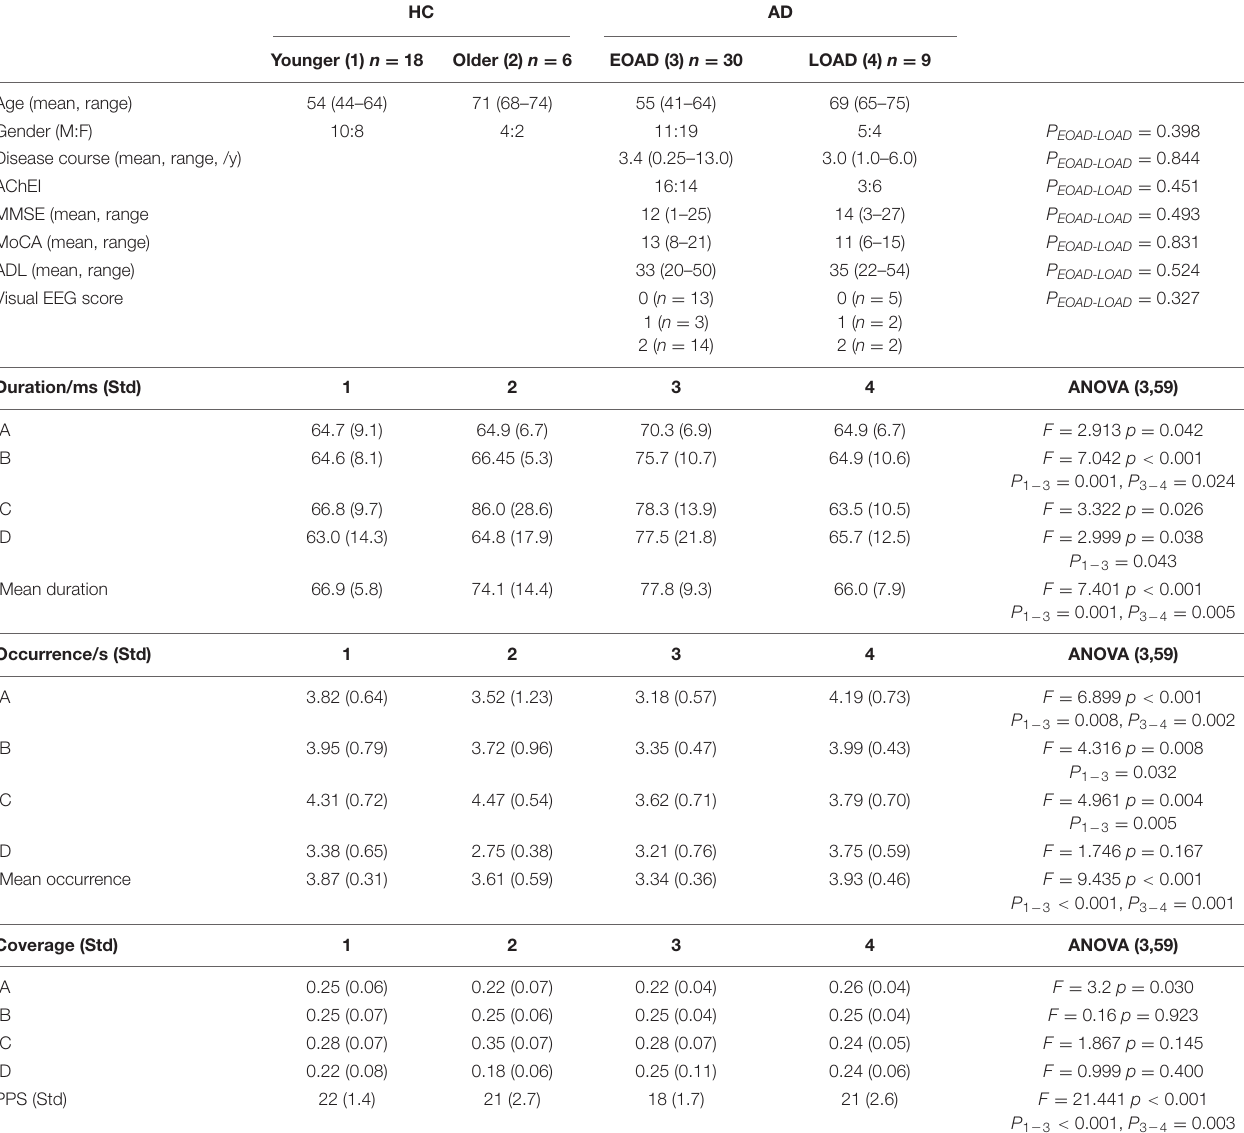
TABLE 4 | Clinical and EEG microstate data in early- and late-onset AD and age-matched